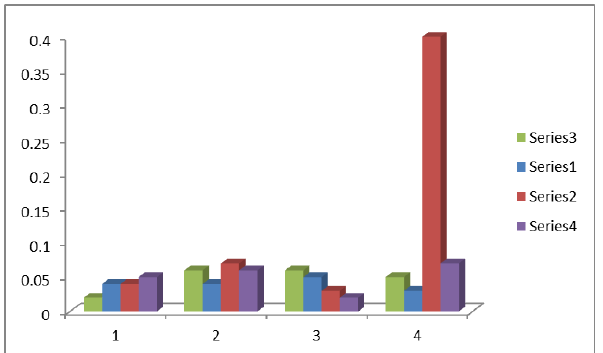
Figure 4. Graph of progress of patient ∂ 2